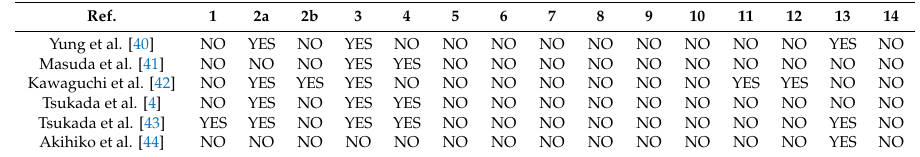
Figure 6. ( a ) Flow chart of the selection of the studies (performed according to the Preferred Reporting Items for Systematic Reviews and Meta-Analyses (PRISMA) [36] guidelines); ( b ) Flow chart of the selection of the patents. Table 6. Assessment of studies using the modified Consolidated Standards of Reporting Trials (CONSORT) checklist